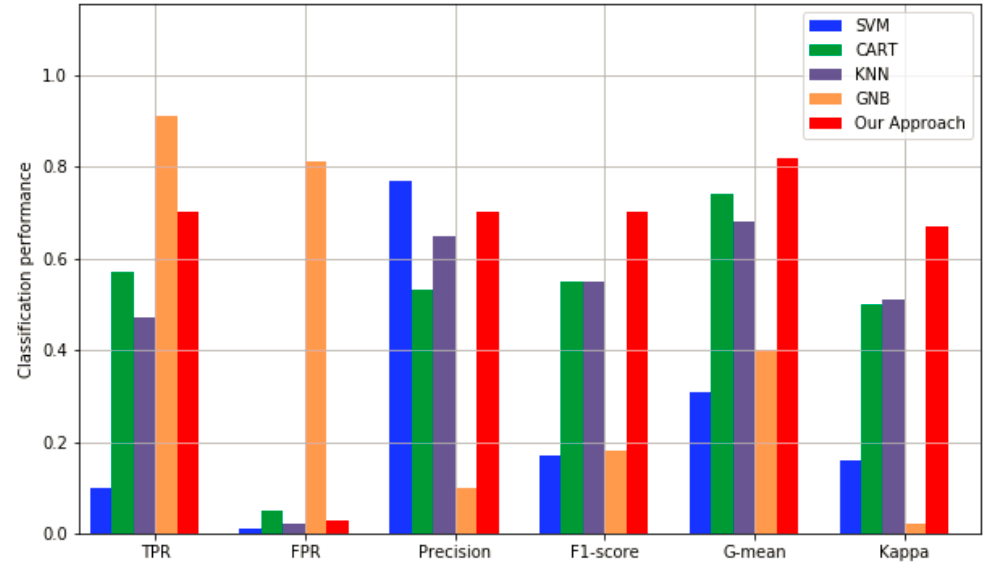
Figure 4. Spam detection performance compared with different machine learning algorithms.